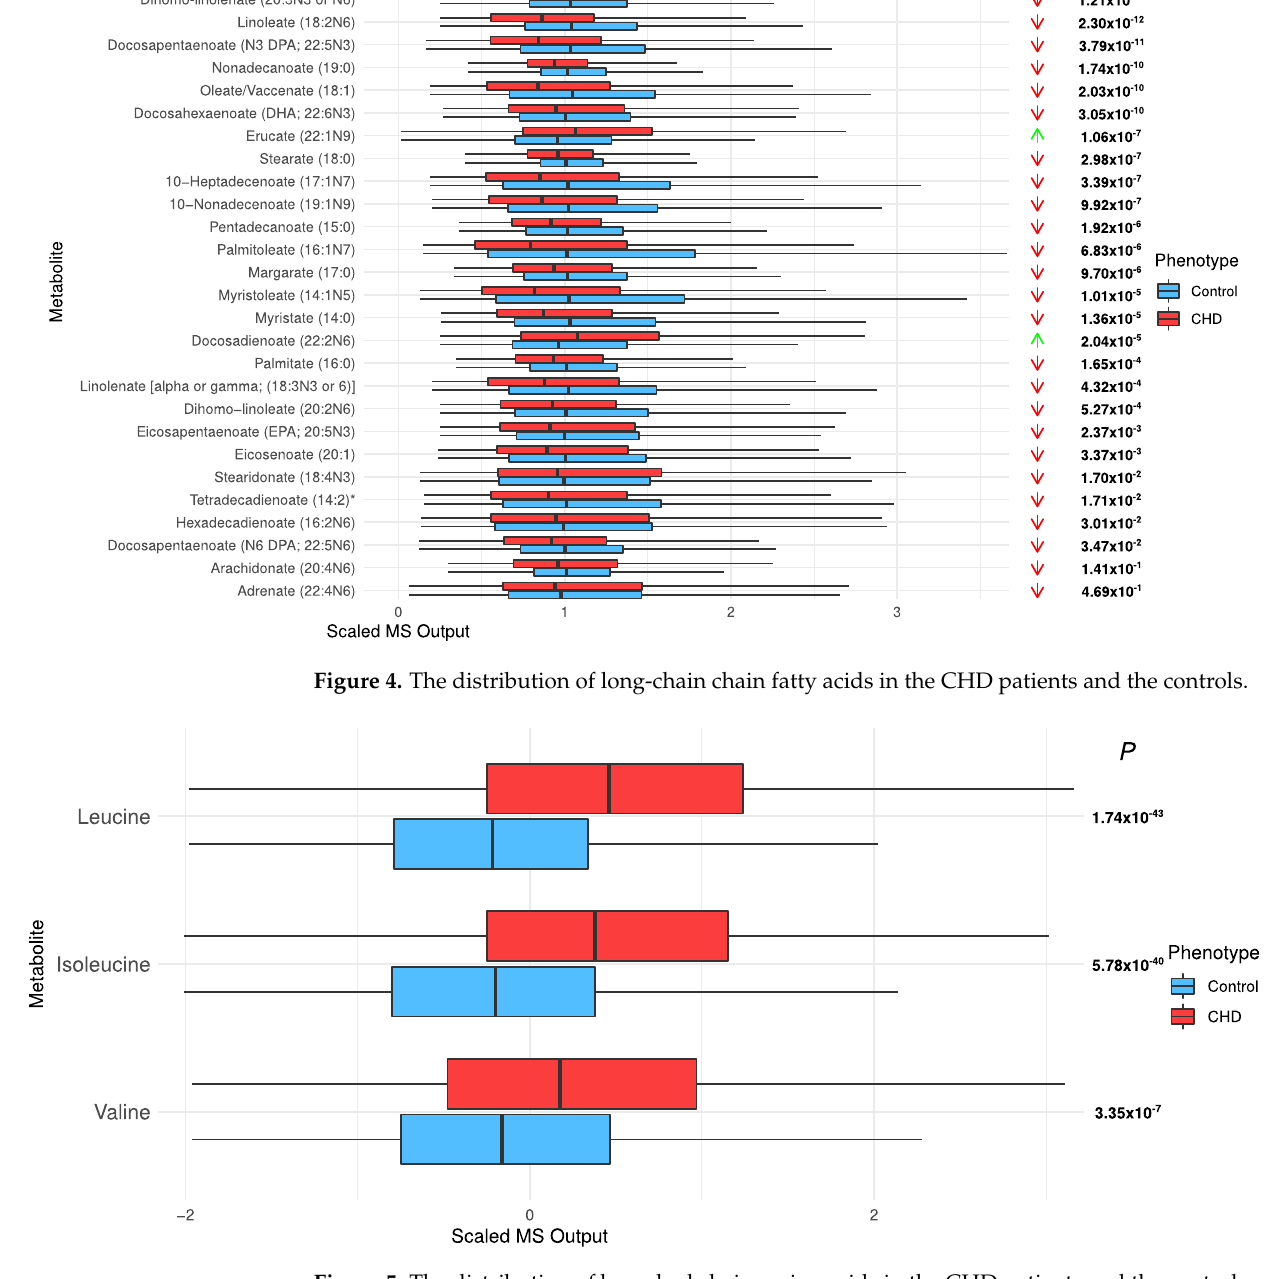
Figure 5. The distribution of branched chain amino acids in the CHD patients and the controls. High concentrations of sphingolipids : Sphingolipids were significantly increased in the CHD patients: sphingosine 1-phosphate (S1P) (FDR p = 4.79 × 10 − 142 ) and sphingosine (FDR p = 8.33 × 10 − 102 ) (Figure 6).